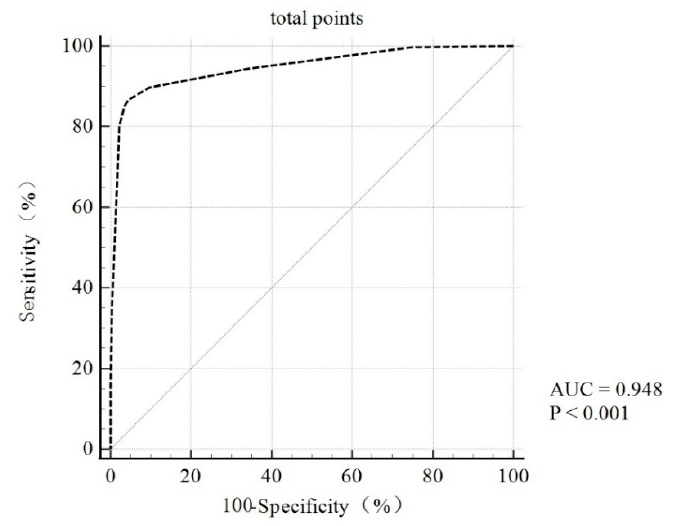
Figure 4. ROC curve of the PC screening scale. ROC: The receiver operating curve; AUC: The area under the curve.